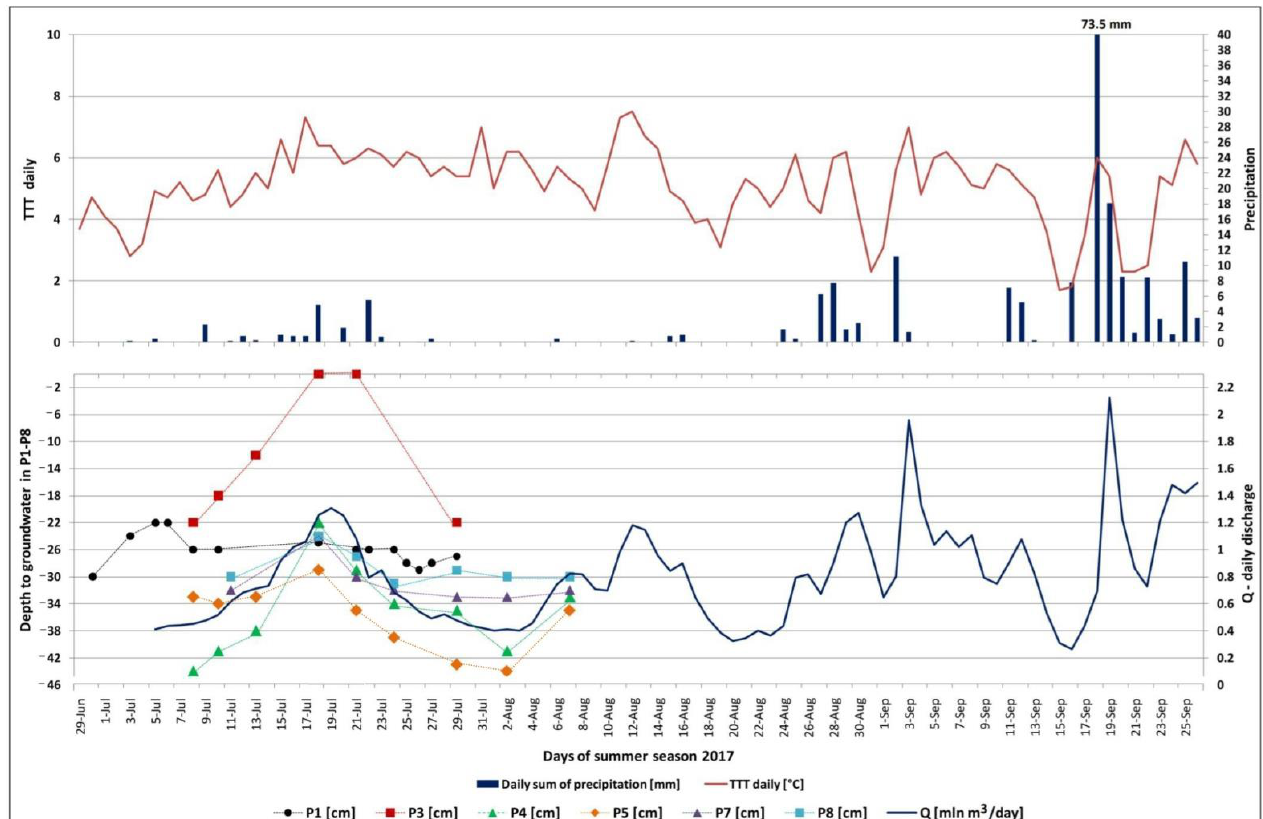
Figure 3. Meteorological and hydrological conditions during the summer season of 2017 in the region of the Werenskioldbreen basin. Meteorological data: Precipitation and TTT (daily mean air temperature)—the Polish Polar Station, Hornsund [61–63]; P1–P8—piezometric network monitoring data, depth to the groundwater table (these are point data; the lines are only auxiliary); the Breelva River’s total daily discharge (Q) is based on hydrometric station data [32,34].